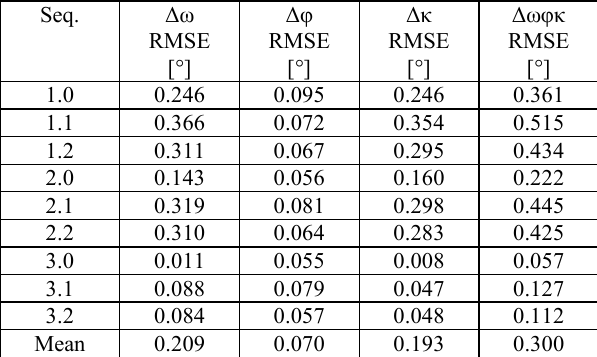
Table 3. Deviations of orientation angles between direct and image-based